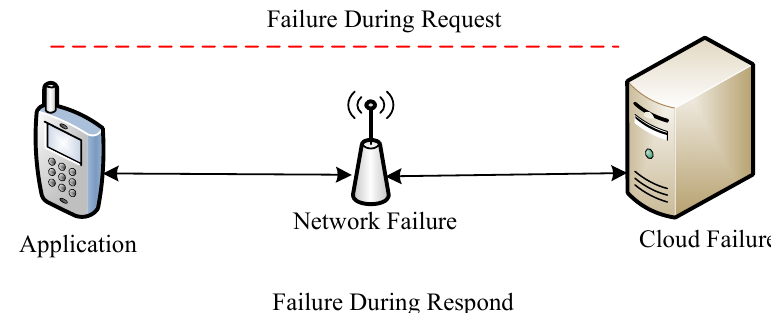
Figure 4. Task-failure scenario.